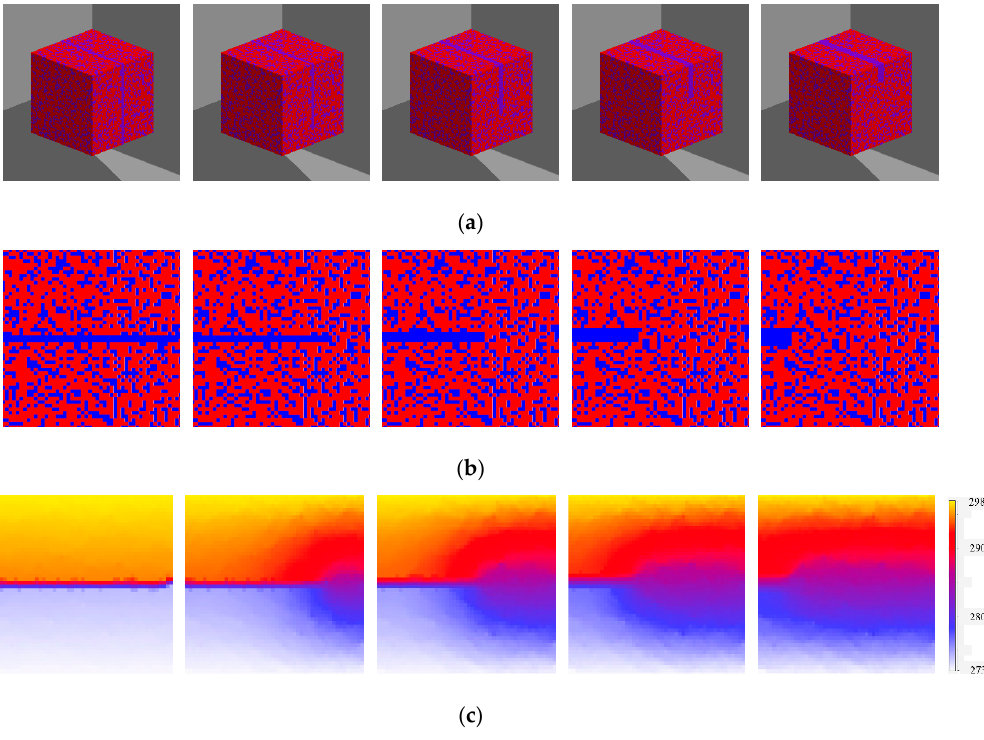
Figure 4. Digital rocks with vertical fractures: ( a ) digital rocks, ( b ) 2D slices, and ( c ) temperature